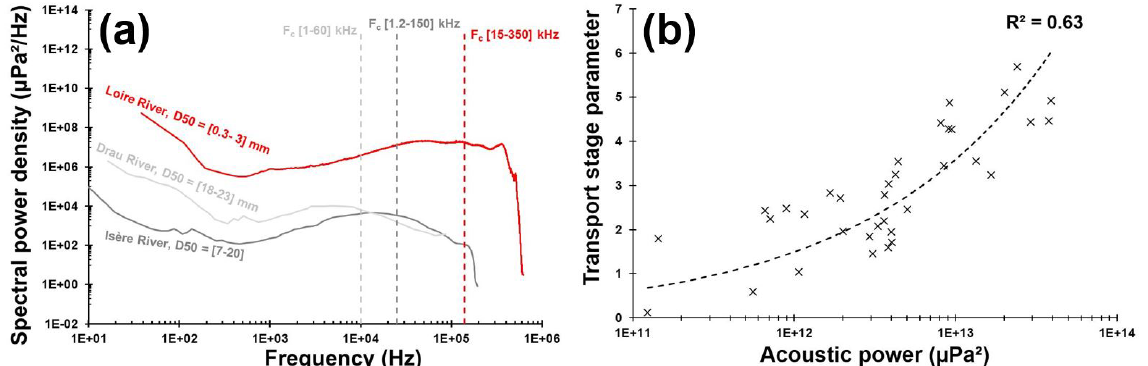
Figure 6. (a) Comparison of PSD from three rivers with varying D 50 (PSD of the Drau River and the Isère River are extracted from a single measurement, PSD of the Loire River is the median PSD from 450 measurements). (b) Transport stage parameter (from Van Rijn, 1984) as a function of acoustic power.